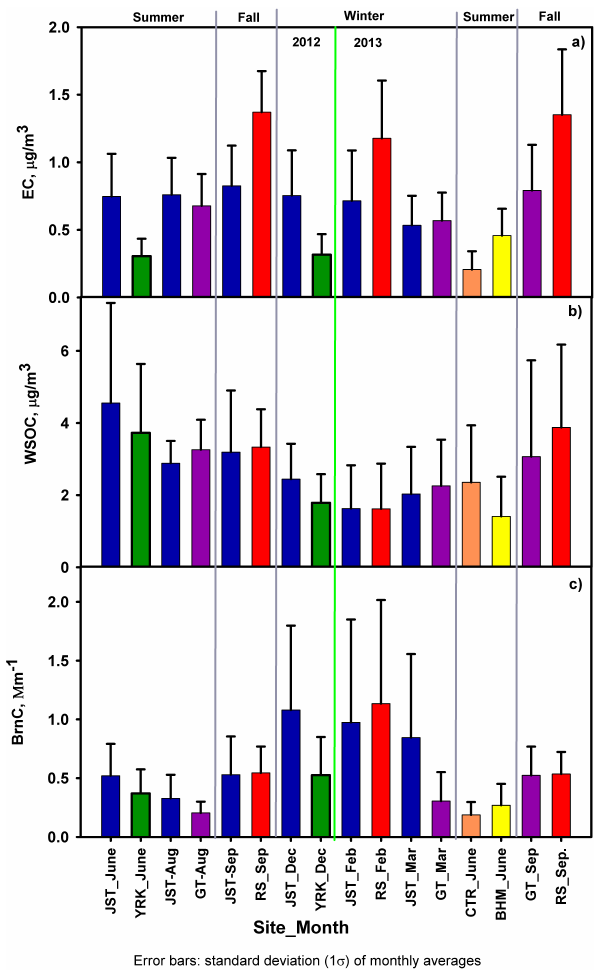
Figure 2. Monthly average ambient concentrations of EC (a) , WSOC (b) , and BrnC (c) at the sampling